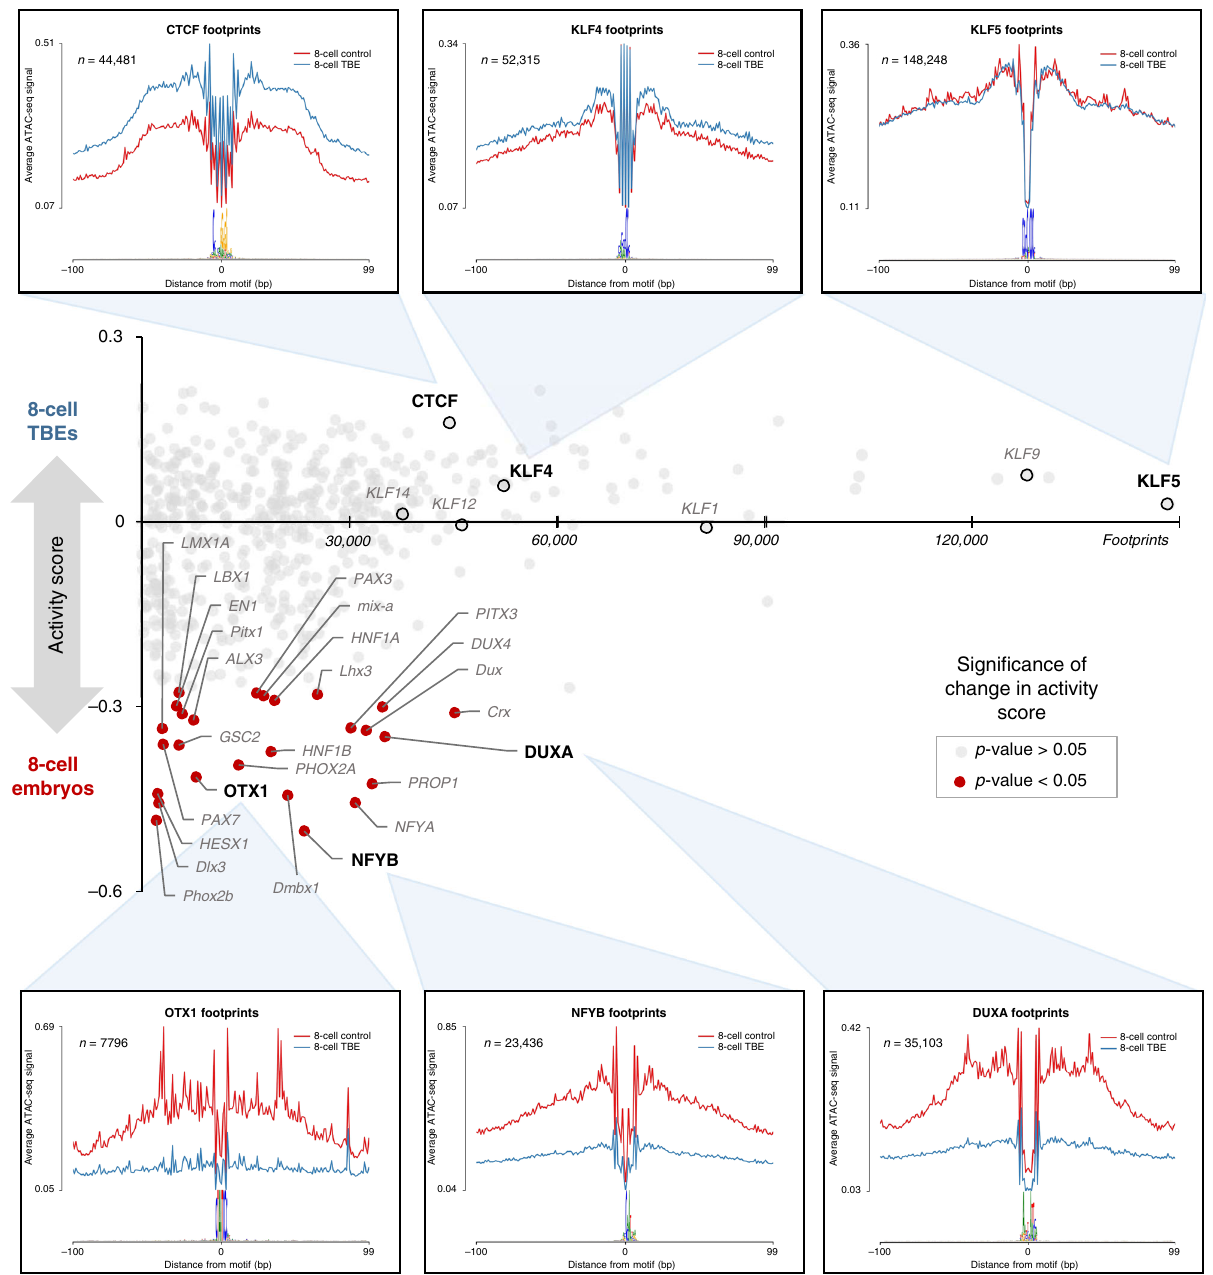
Fig. 5 Differential transcription factor binding activity in 8-cell control and TBEs. TFs marked in red demonstrated signi fi cantly reduced binding activity when embryonic transcription was inhibited ( p value < 0.05; two-tailed t test). Average ATAC-seq signal around footprints is shown for select TFs, including three TFs with no signi fi cant change in binding activity (top) and three TFs with signi fi cantly reduced binding activity in TBEs (bottom). Source data are provided as a Source Data fi